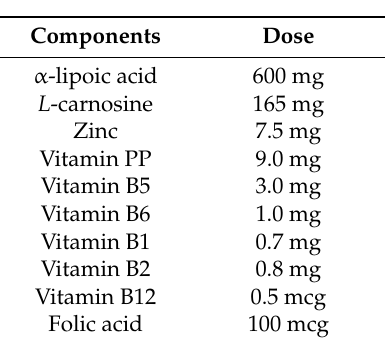
Table 2. Food supplement